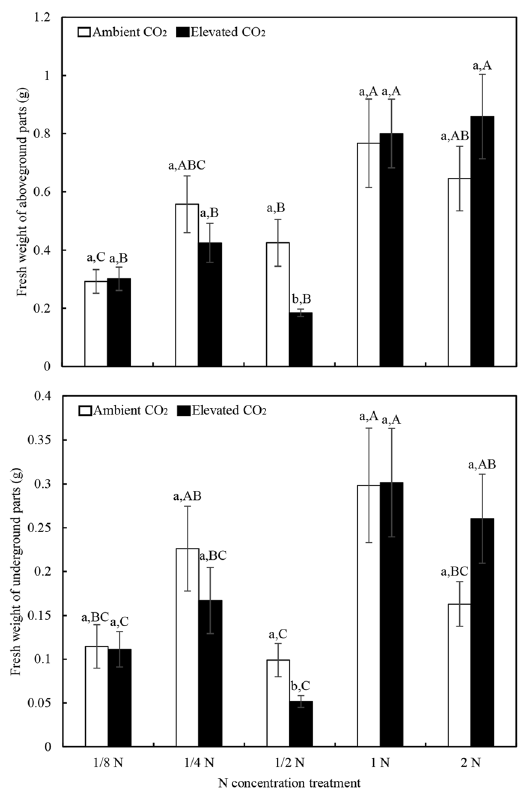
Figure 2. Aboveground ( A ) and belowground ( B ) biomass of transgenic Bt rice plants grown under ambient and elevated CO 2 at different N-fertilizer augmentation rates. Different lowercase and uppercase letters indicate significant differences between the ambient CO 2 and elevated CO 2 within N-fertilizer rates, and between the different N-fertilizer rates within CO 2 level by LSD test at P <